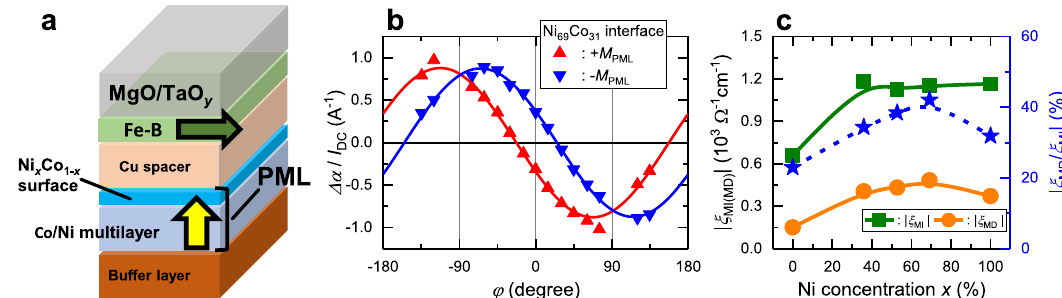
Fig. 4 Interface band engineering of charge-to-spin conversion. a Schematic of stack structure used for interface engineering (Series C samples). Ni concentration of the 0.4 nm-thick Co-Ni alloy layer near to the Cu interface (light blue region) is modulated. b Angular dependence of damping modulation ef fi ciency Δα = I DC in Co 31 Ni 69 interface sample. Red (blue) data shows the measurement in the + M PML ( − M PML ) state and solid curve shows fi tting results using Eq. (2). c Ni-concentration ( x ) dependence of absolute value of ξ MI (left axis: green) ξ MD (left axis: orange), and | ξ MD / ξ MI | (right axis: star symbol). Solid line is a guide for